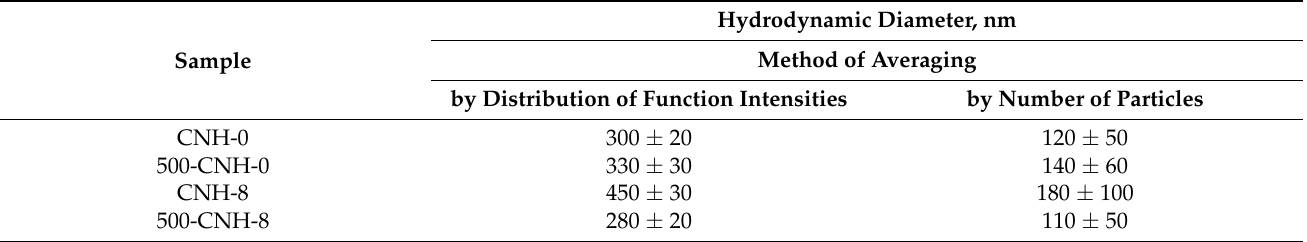
Table 2. Hydrodynamic diameters of particles of initial and thermally oxidized CNHs in water obtained by averaging over distribution of function intensities and number of